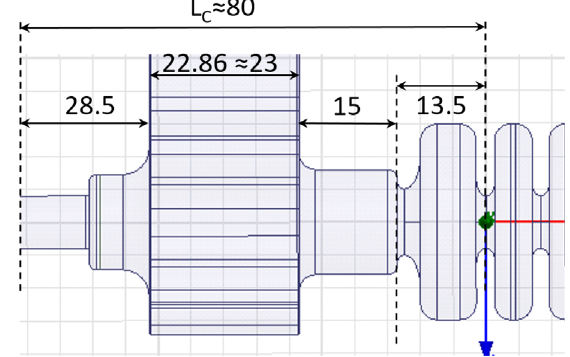
FIG. 13. Geometry of the input rf power coupler including beam pipe (28.5 mm), E-rotator ( ≈ 23 mm), circular wave-guide (15 mm) and the matching cell (13.5 mm). The total length of the input coupler L is approximately 80 mm. c